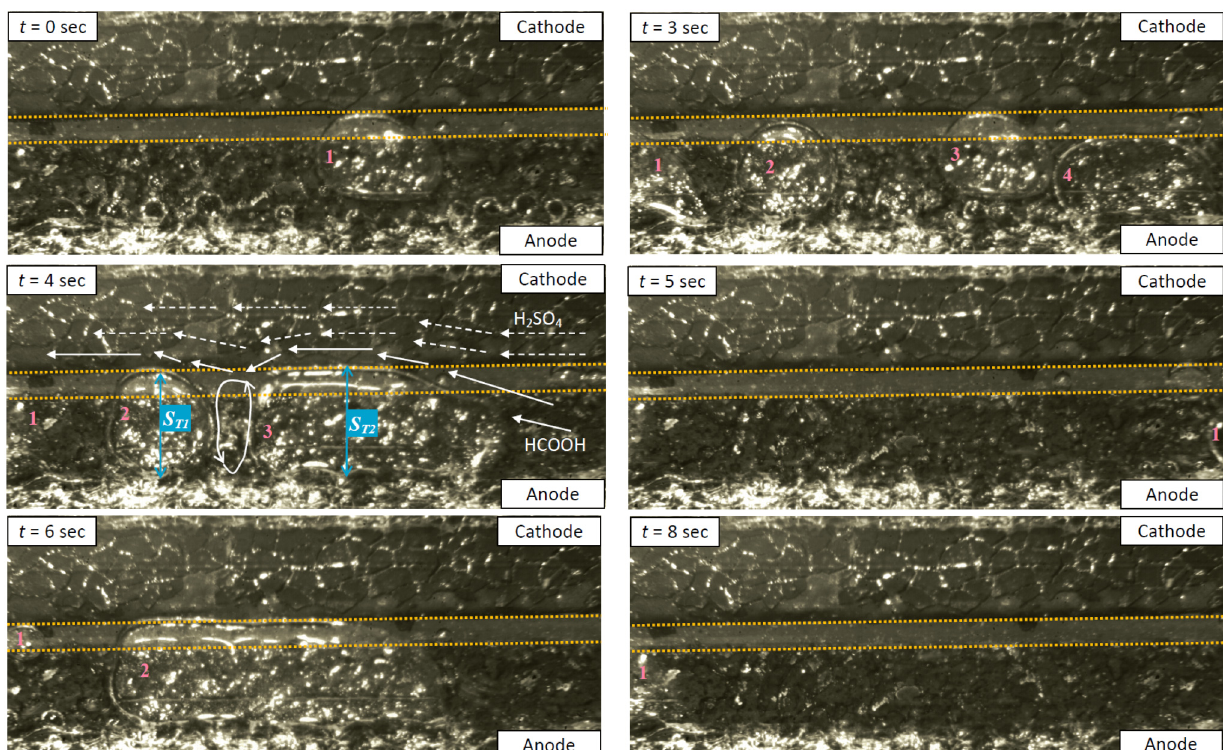
Figure 7. A series of bubble growth during period F in the middle section of the microchannel of the fuel cell operated with 0.5-M HCOOH at a flow rate of 0.7 mL/min. The parallel dashed lines in the pictures denote the spacing between anode and cathode and the liquid flows toward the left of the